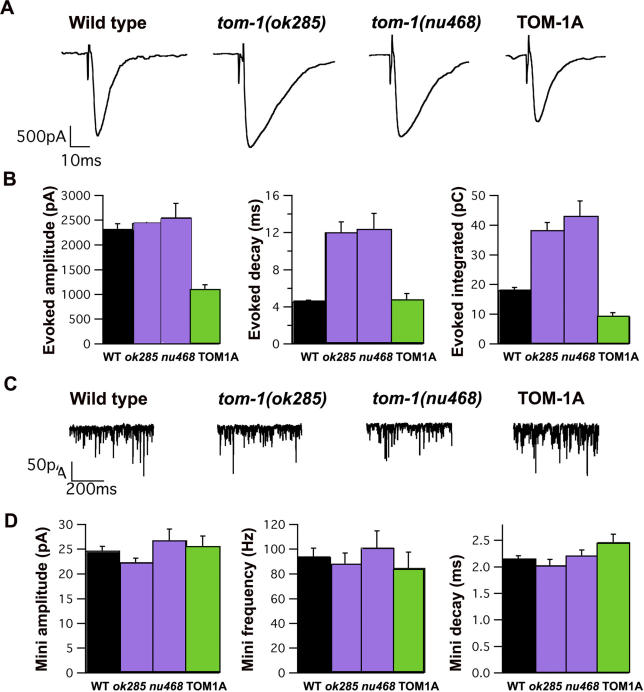
Electrophysiological Phenotypes of
tom-1 Mutants
(A) Electrophysiological recordings from NMJs of dissected worms, revealed a pronounced increase in evoked response duration in both
tom-1 mutant alleles
(ok285 and
nu468) that is reversed in
jaIs1052, expressing TOM-1A in cholinergic neurons of
tom-1(nu468)
.
(B) Analysis of evoked responses detected as inward currents from voltage-clamped body wall muscles in response to 2 ms depolarizing ventral cord stimuli. Evoked amplitude (pA) is normal in
tom-1 mutants and decreased in
jaIs1052 (left). Half-time–evoked response decay (ms) is increased in
tom-1 mutants and restored to normal levels in
jaIs1052 (middle). Total charge integral is increased in
tom-1 mutants and reduced in
jaLs1052 (right).
(C) Representative endogenous miniature postsynaptic events.(D) Event amplitude (left), frequency (middle), and decay rates (right) were normal in
tom-1 mutants and
jaIs1052.. Data expressed as mean ± SEM.